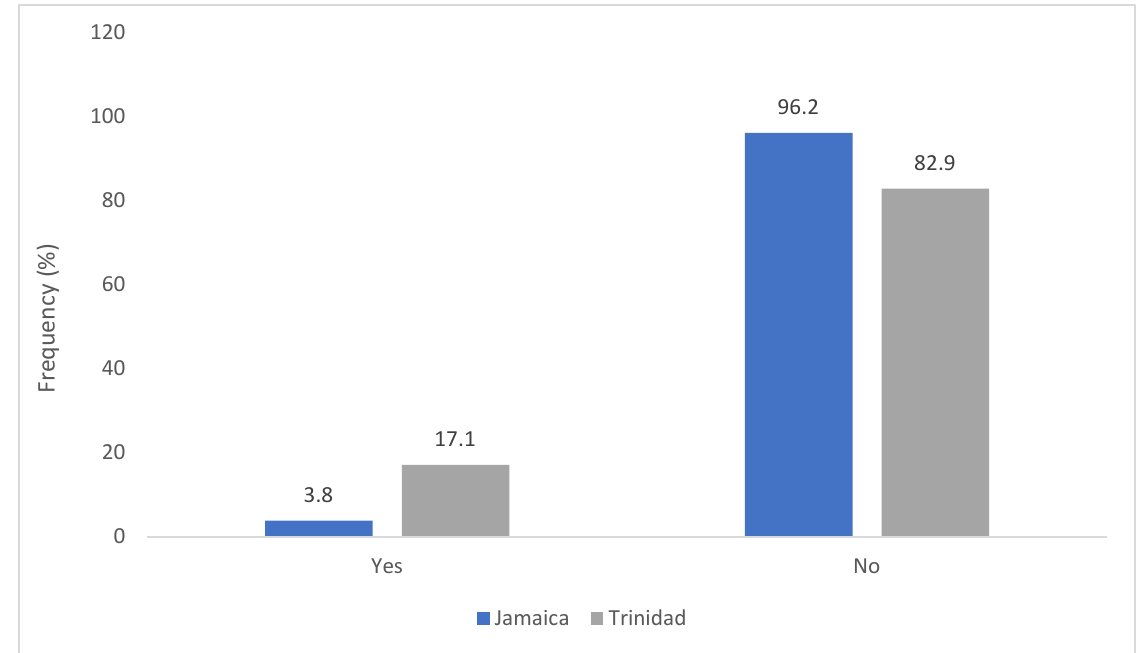
Figure 5. The presence of written antibiotic policies in clinics of Jamaica vs. Trinidad .